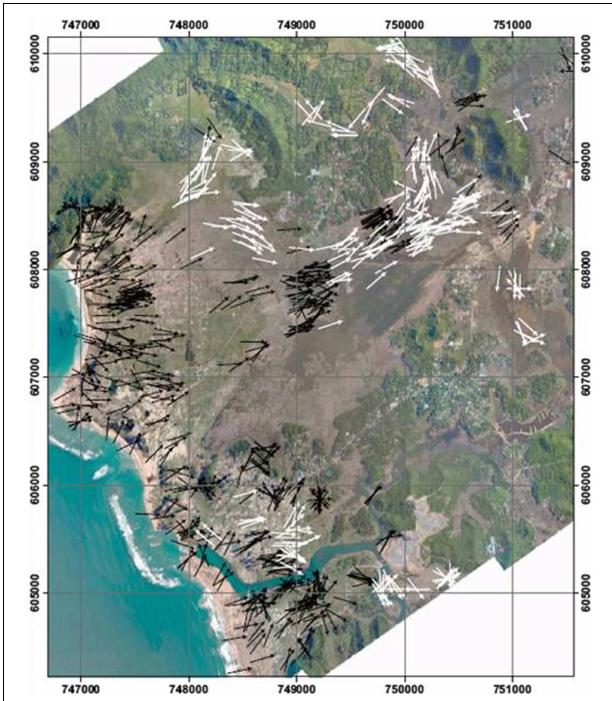
FIGURE 9 | 2004 IOT flooding directions evidenced from the orientation of elongated material laying on the ground after the event as tree trunks, poles, fence posts (from Grancher et al.,